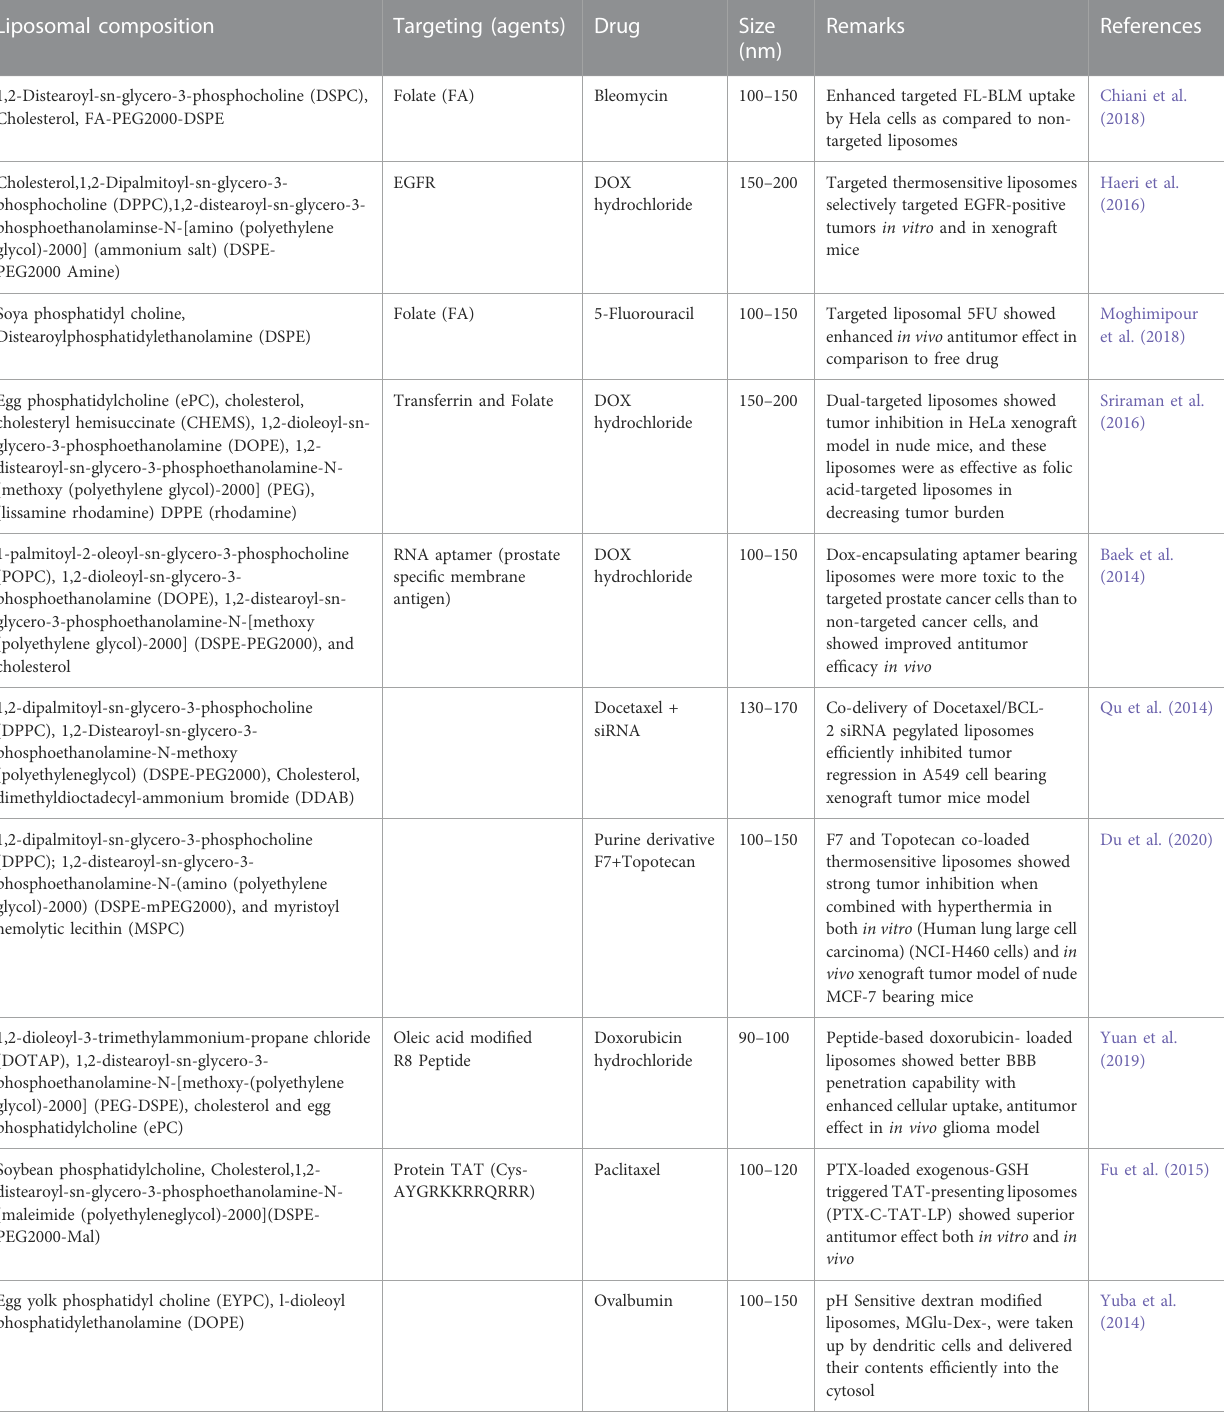
TABLE 1 Examples of liposomal